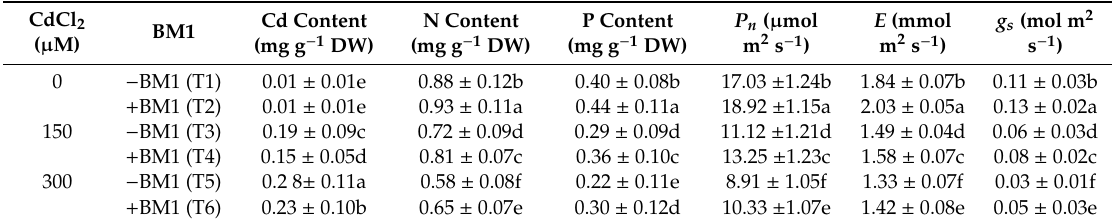
Table 2. Minerals uptake, photosynthesis rate ( P n ) , transpiration rate ( E ) and stomatal conductance ( g s ) in leaves of un-inoculated and inoculated soybean plants with Serratia marcescens BM1 under Cd